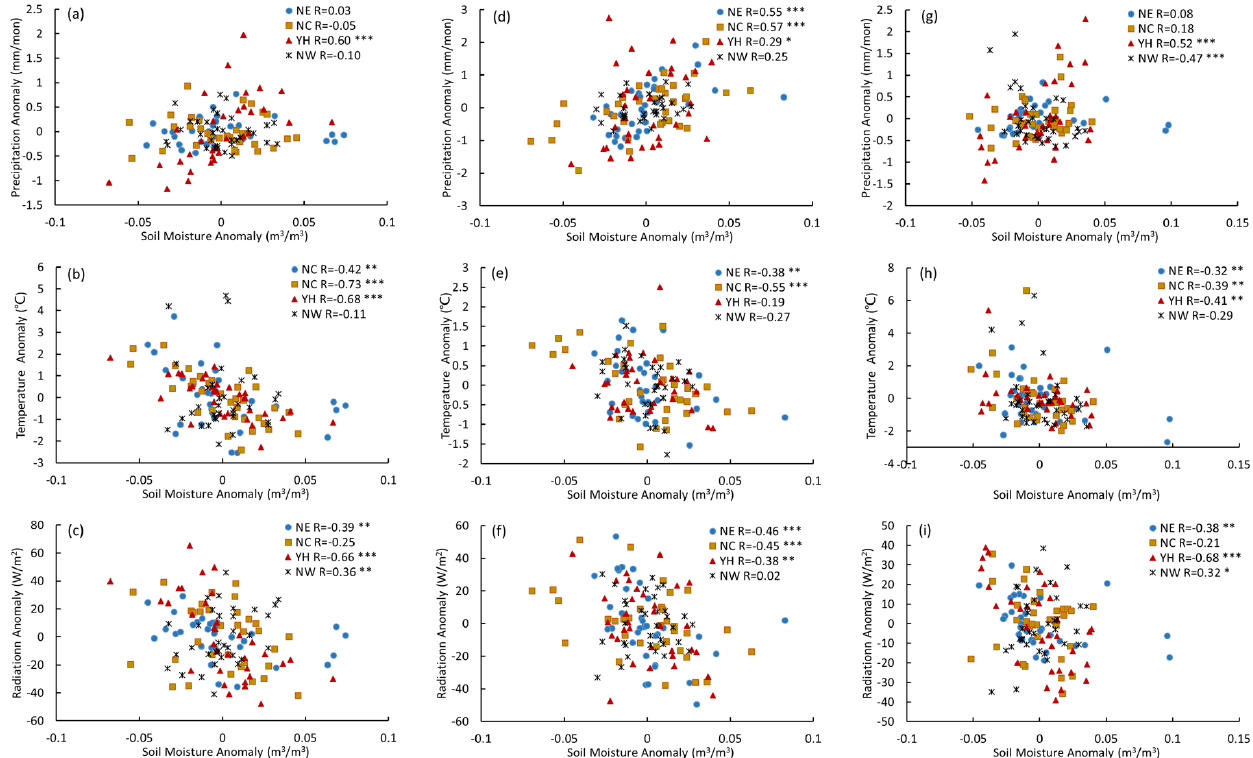
Figure 12. Scatterplots of monthly anomalies of (a, d, g) precipitation, (b, e, h) temperature, and (c, f, i) net radiation vs. observed soil moisture in the top 10cm depth during 1981–2013 during (a–c) MAM, (d–f) JJA, and (g–i) SON seasons. R is the correlation coefficient over four research regions, and the values marked with ∗ , ∗∗ , and ∗∗∗ indicate that the correlation coefficient has passed the significance test of 90%, 95%, and 99%,